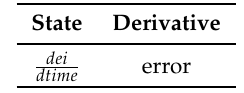
Table 3. ODE page of classical control (SISO